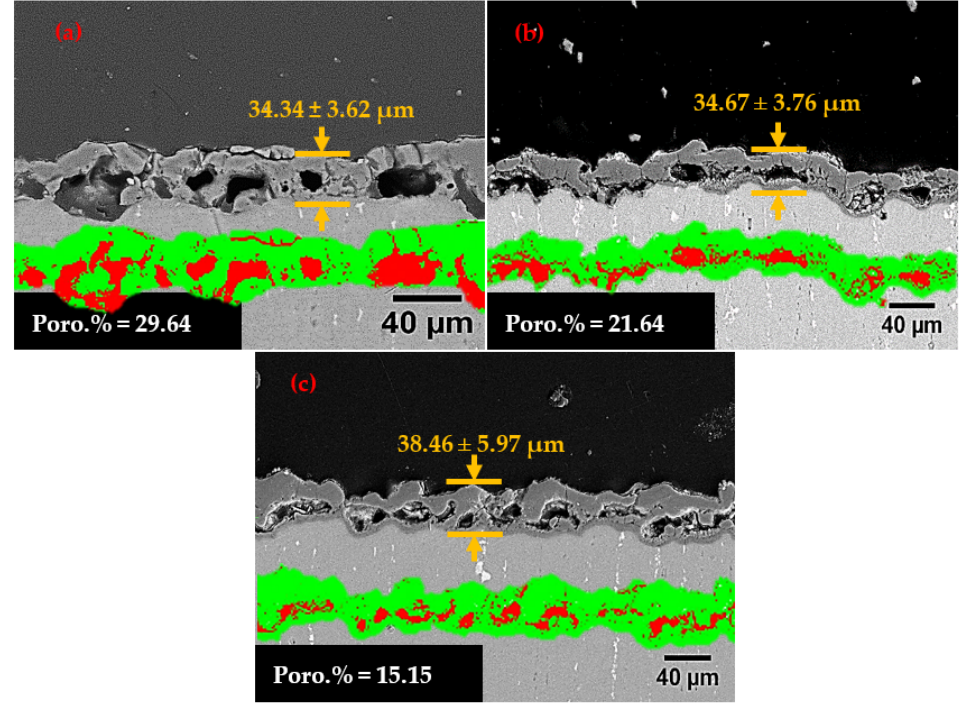
Figure 3. FESEM cross ‐ sections of the coatings prepared in the presence of various Na 2 MoO 4 concentrations: ( a ) Mo ‐ 0, ( b ) Mo ‐ 3, and ( c ) Mo ‐ 5. The images inserted below of each cross ‐ sectional view demonstrate the porosity percentage (red areas) using MIP software.